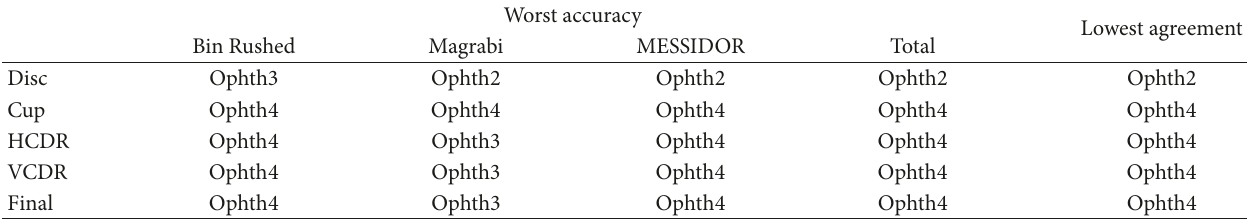
Table 18: The worst accuracy and agreement for all the four parameters and the three images